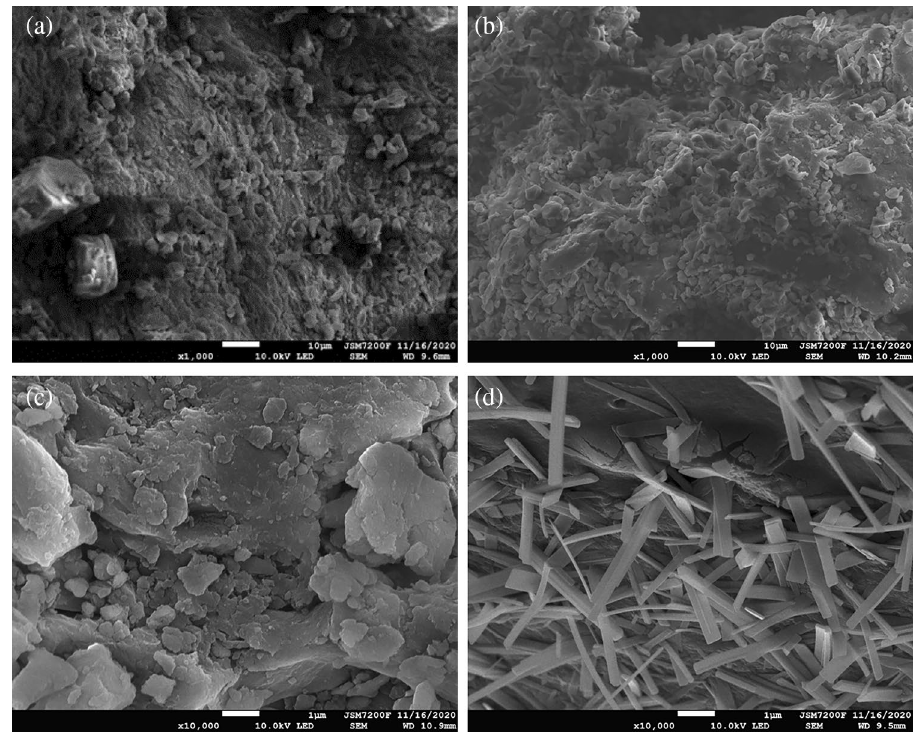
Figure 8. SEM images of SRB-LP and R-SRB-LP. ( a ) SEM image of SRB-LP before AMD treatment. ( b ) SEM image of SRB-LP after AMD treatment. ( c ) SEM image of R-SRB-LP particles before AMD treatment. ( d ) SEM image of R-SRB-LP after AMD treatment.